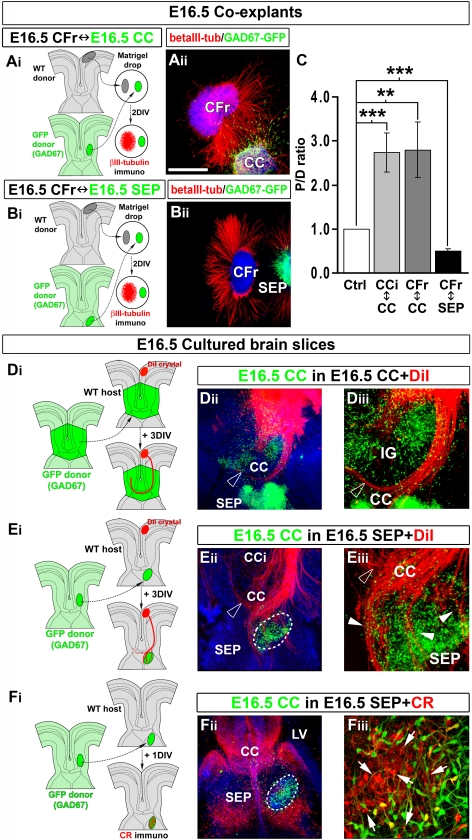
CC region enriched in both types of neurons attracts callosal axons.(A–C) Experimental paradigms used to determine whether the CC (Ai) and the SEP (Bi) exert attractive or repulsive effects on cortical axons. (Aii and Bii) Immunohistochemical staining for βIII-tubulin on E16.5 frontal cortex (CFr) cocultured with E16.5 GAD67-GFP+ CC (Aii) or SEP (Bii). (C) Quantification of the axonal guidance responses to E16.5 CC and SEP explants. Data are expressed as a P/D ratio, where P and D are the mean fluorescence ±SEM intensity in the quadrants proximal and distal to the CC or SEP explants. Double asterisks (**) indicate significantly different with p<0.01; triple asterisks (***) indicate significantly different with p<0.001. CC neurons cause strong chemoattraction on cingulate (CCi) and frontal axons, whereas the SEP is repulsive. (Di) In vitro model of organotypic slices at E16.5 used to study callosal axon navigation through CC after transplantation of E16.5 CC and surrounding regions. (Dii–Diii) GAD67-GFP+ neurons maintain their initial organization through the explant after 3 d in vitro. DiI-labeled callosal axons grow normally and cross the CC midline within the large GAD67-GFP+ CC explant. (Ei) Experimental paradigm used to determine whether the CC neurons exert attractive effects on callosal axons. To test this hypothesis, a small explant of E16.5 GAD67-GFP+ lateral CC containing GABAergic and glutamatergic neurons is transplanted in the nonpermissive septal region. (Eii–Eiii) DiI staining showing that callosal axons penetrate the SEP toward the CC explant enriched in both type of neurons. (Fi–Fiii) CR immunostaining showing that E16.5 lateral CC explants obtained from GAD67-GFP transgenic mice contained CR-positive glutamatergic neurons (arrows) in addition to GABAergic interneurons. Brain tissues in (Aii, Bii, Dii, Eii, and Fii) were counterstained with Hoechst. Bar indicates 485 µm in (Bii), 435 µm in (Aii, Dii, Eii, and Fii), 220 µm in (Diii and Eiii), and 70 µm in (Fiii). LV, lateral ventricle.